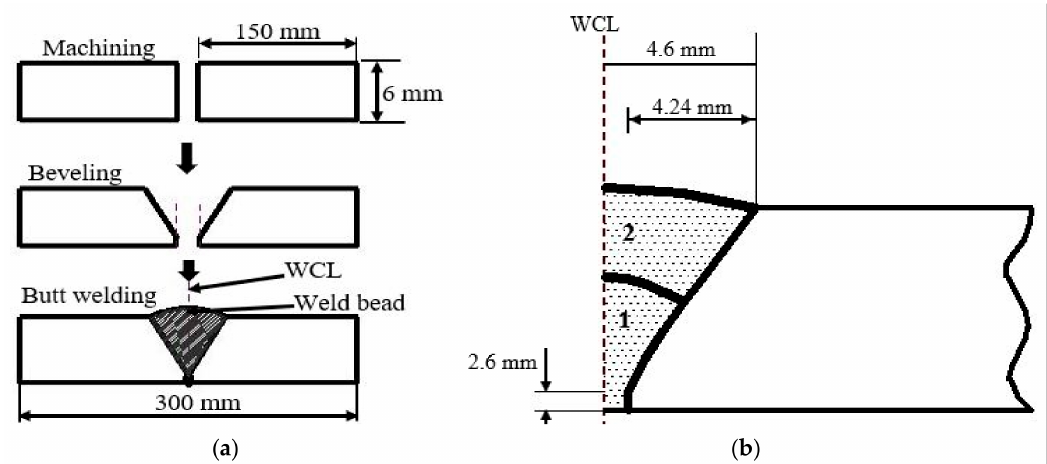
Figure 6. Experimental sequence. ( a ) the machining and manufacturing processes; ( b ) description of the weld-passes and groove dimension.